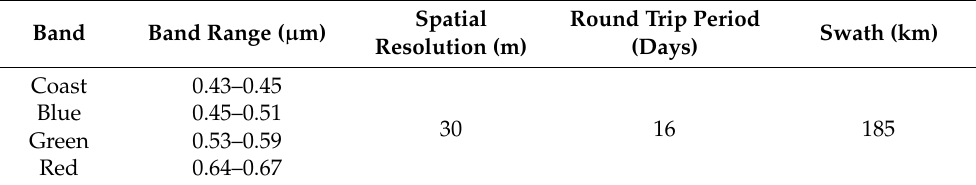
Table 2. Visible bands characteristics of Landsat8 OLI